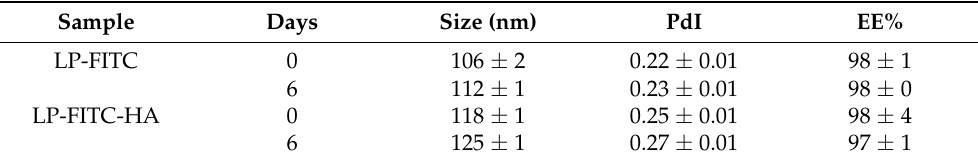
Table 6. Storage stability test of FITC-loaded liposomes (LP-FITC) and TQ-loaded liposomes coated with HA (LP-FITC-HA) at +4 ◦ C for 6 days (Mean ± SD, n = 3).